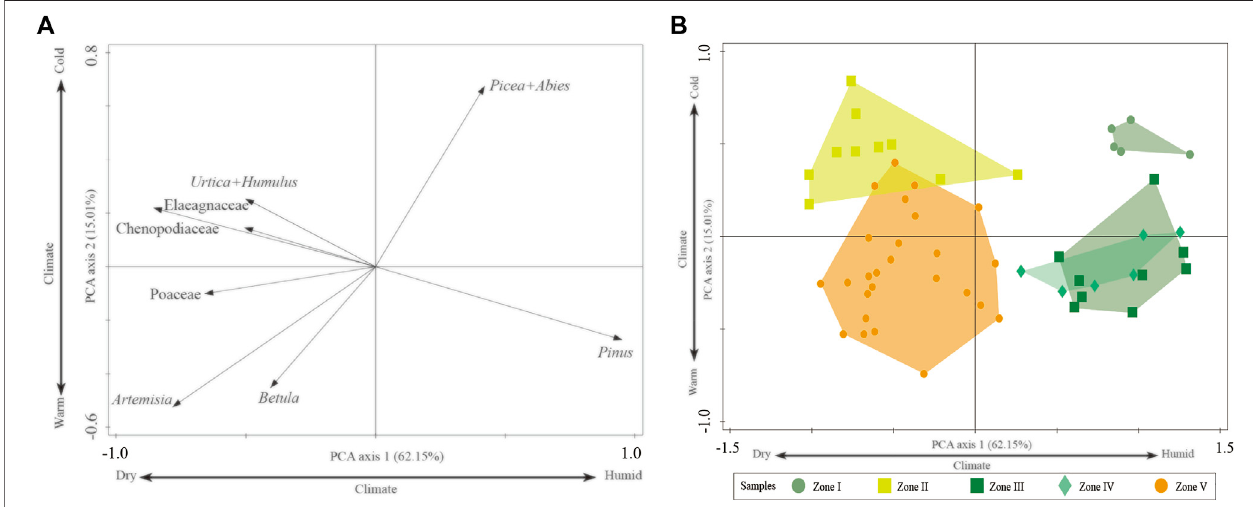
FIGURE 4 | PCA results for the pollen spectra from the Banshan site. (A) : variable loadings on axes 1 and 2, and (B) sample loadings on axes 1 and 2.